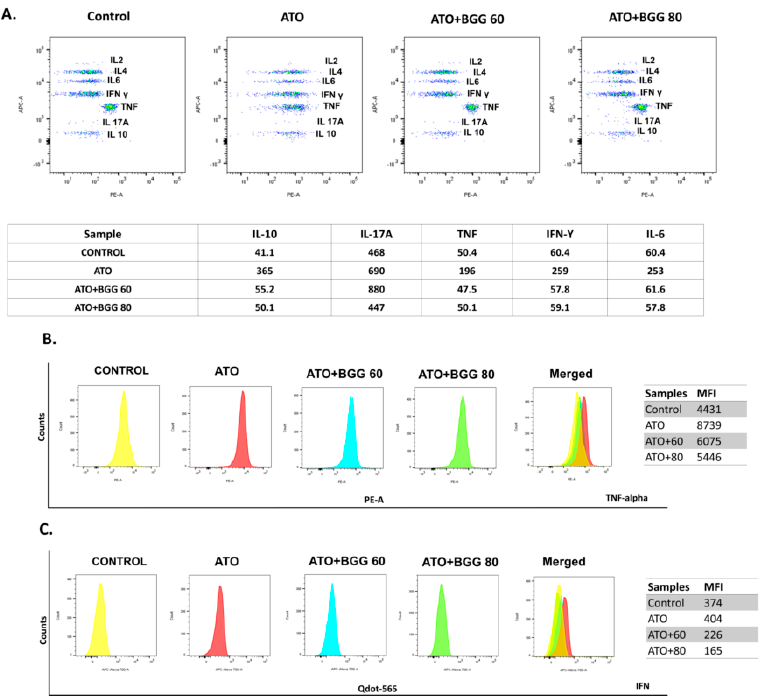
Figure 3. Extracellular cytokine interleukins measured by CBA bead assay, using flow cytometry in ( A) RAW 264.7. Intercellular cytokines measurements by flow cytometry ( B ) TNF-alpha and ( C ) IFN-gamma. 3.5.2. Intracellular Staining of Interleukins To evaluate the immunomodulatory effect of BGG against As-induced toxicity in